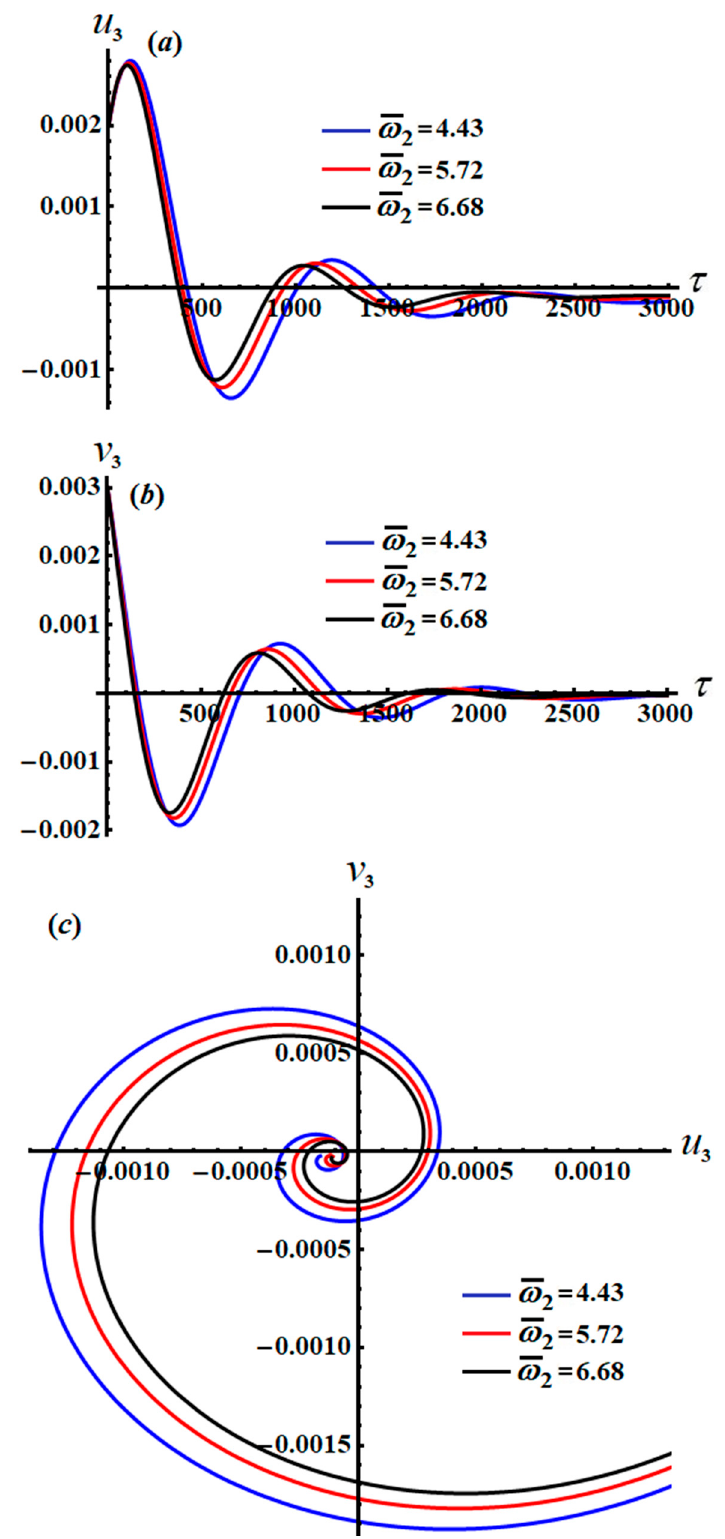
τ Figure 20. The modified amplitudes via and the projections of the modulation equation tracks Figure 20. The modified amplitudes via τ and the projections of the modulation equation tracks on on the phase plane the phase plane u 3 v 3 : ( a – c ) when ω 2 = ( 4.43,5.72,6.68 )